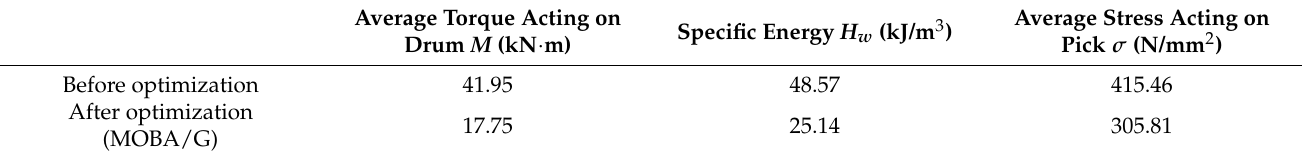
Table 5. Objective functions before and after optimization.